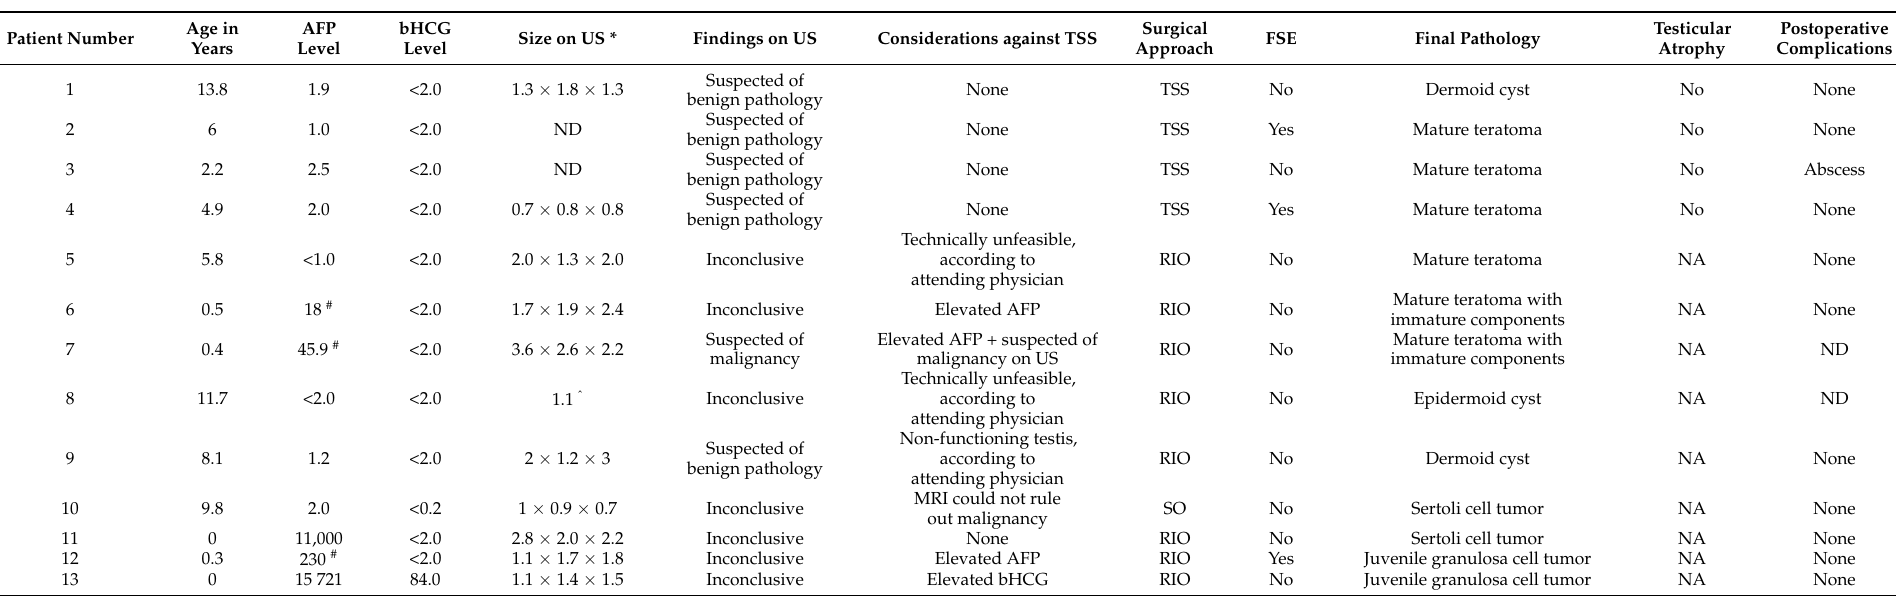
Table 3. Characteristics of boys with a benign GCT or SCST in which TSS could have been considered, based on their histopathology, according to the